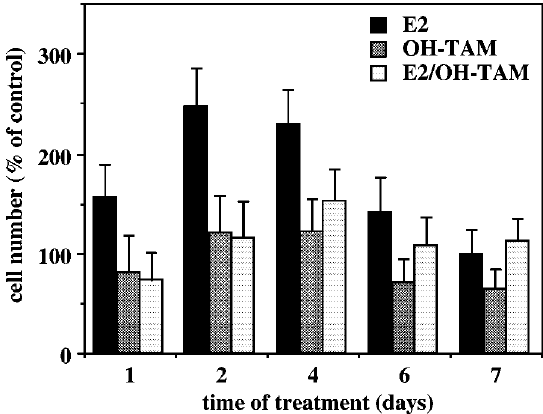
Fig. 1. Effect of treatment on MCF-7 cell proliferation. The values represent the percentage of control cells. Data are the mean and stan- dard deviation from four sets of